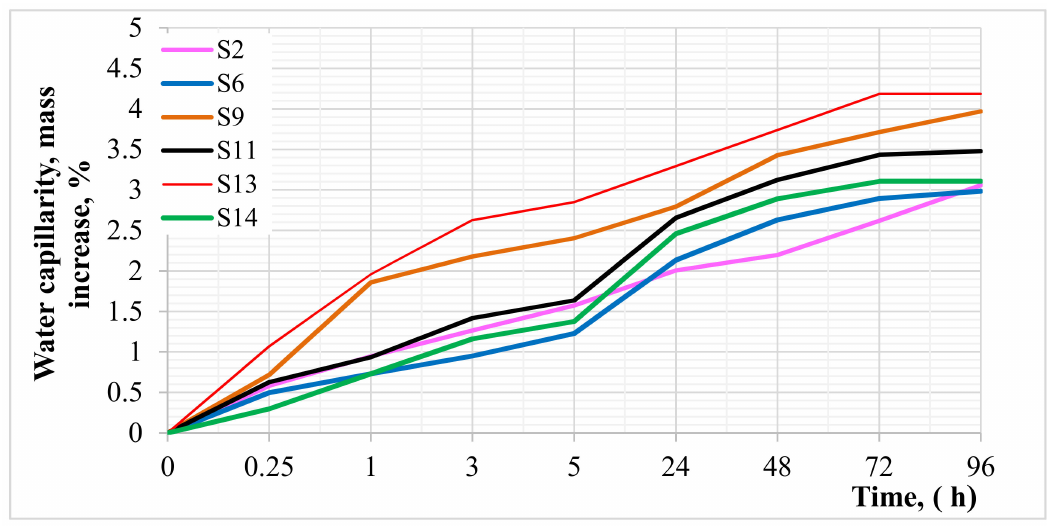
Figure 17. Average values of water capillarity as percent mass increase for selected